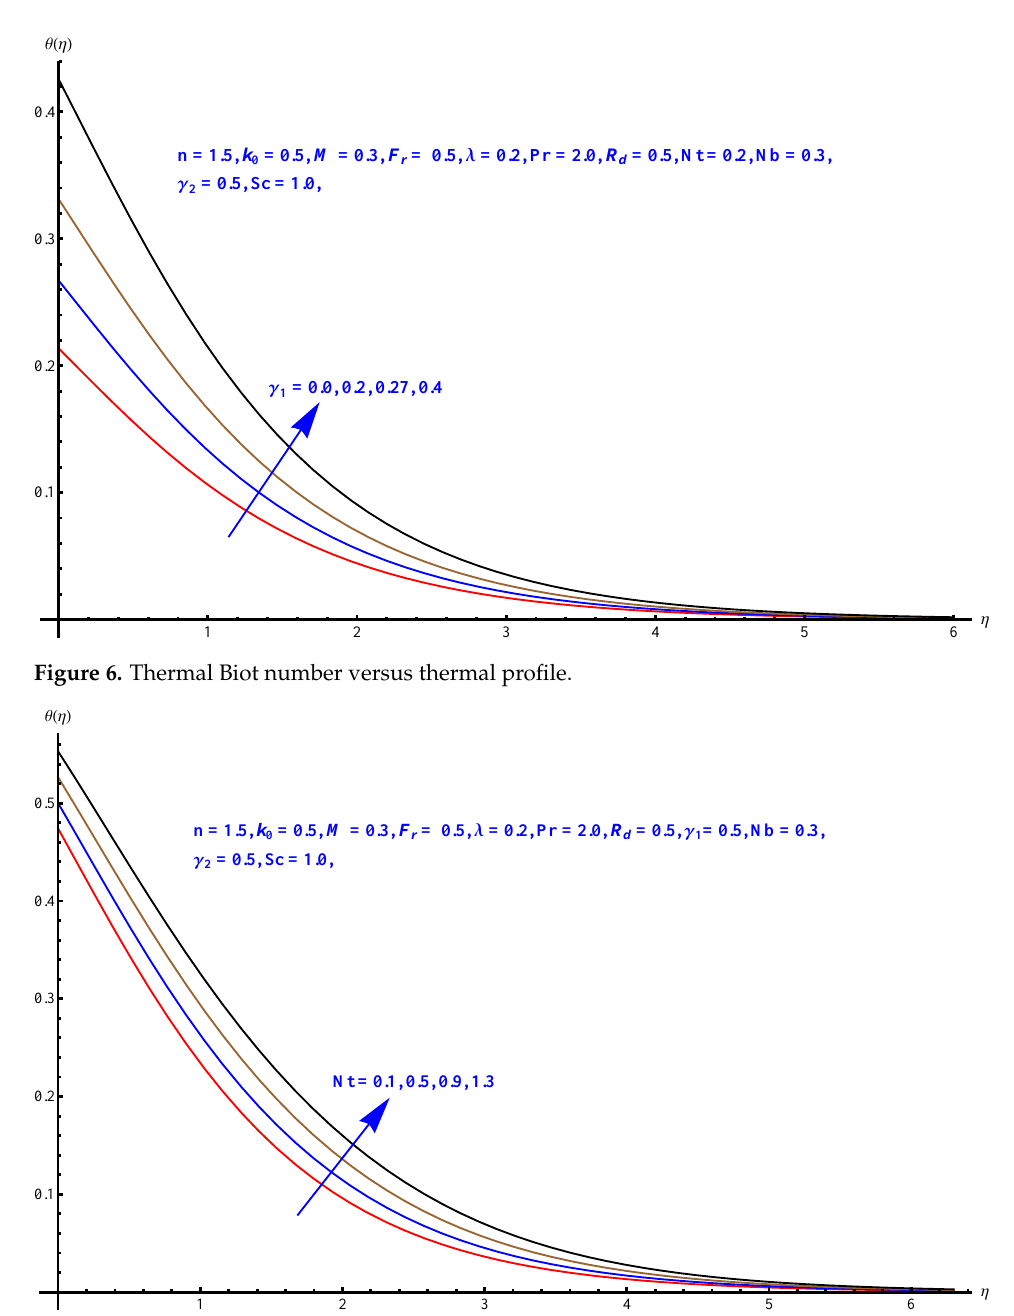
Figure 7. Thermophoresis versus thermal